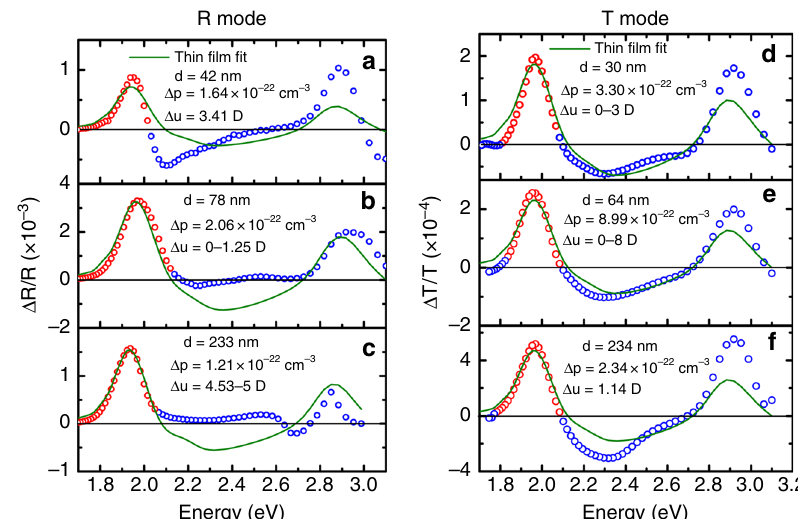
Fig. 2 Thin fi lm absorbance fi tting. a – c Re fl ection mode electromodulation (EM) fi tted with thin fi lm absorbance. d – f Transmission mode EM fi tted with thin fi lm absorbance. The thickness d of the active layer was measured by pro fi lometer. The red symbols represent the 1st excitonic regions which are being fi tted in the All the EM spectra follow the linear dependence on the electrical fi eld strength as described by the Stark theory 23 as demonstrated in Supplementary Fig. 6.